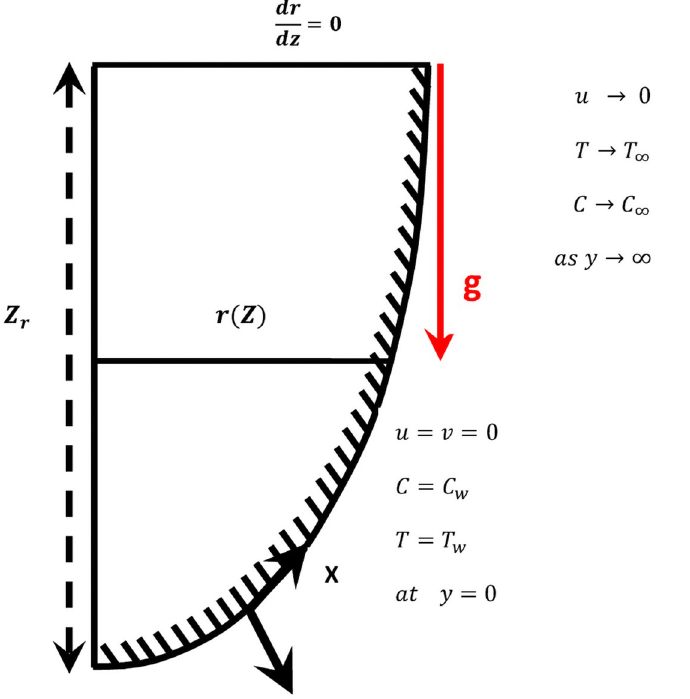
Fig 1. Flow geometry and the coordinate